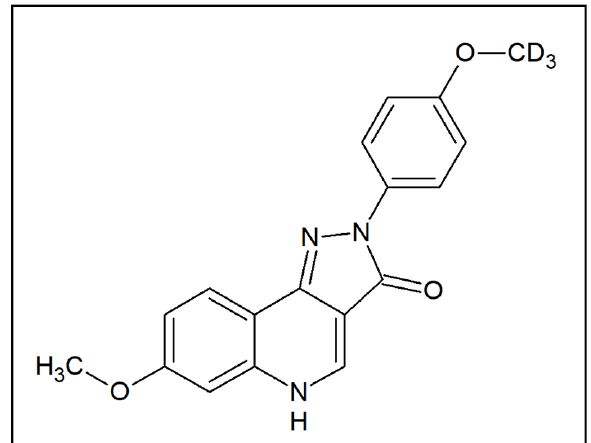
Figure 1. Chemical structure of DK-I-56-1.